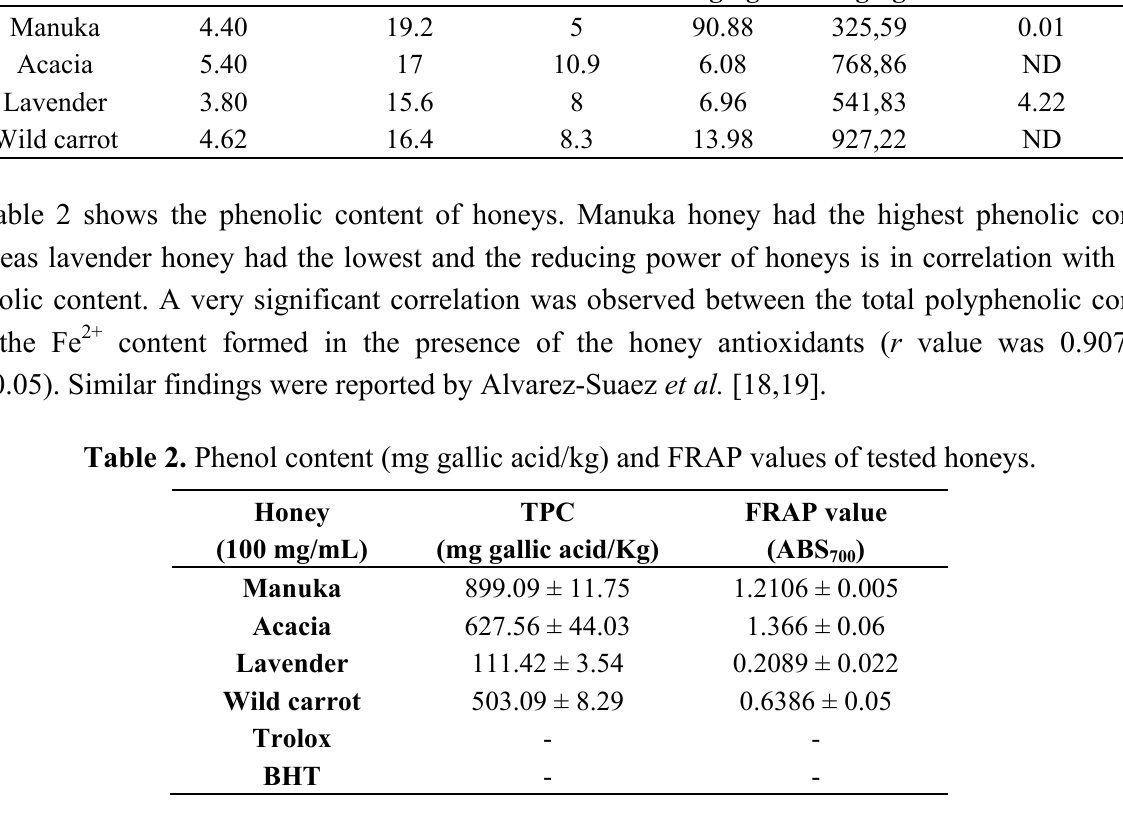
Table 1. Values of physicochemical properties of the different varieties of honey. Honey type